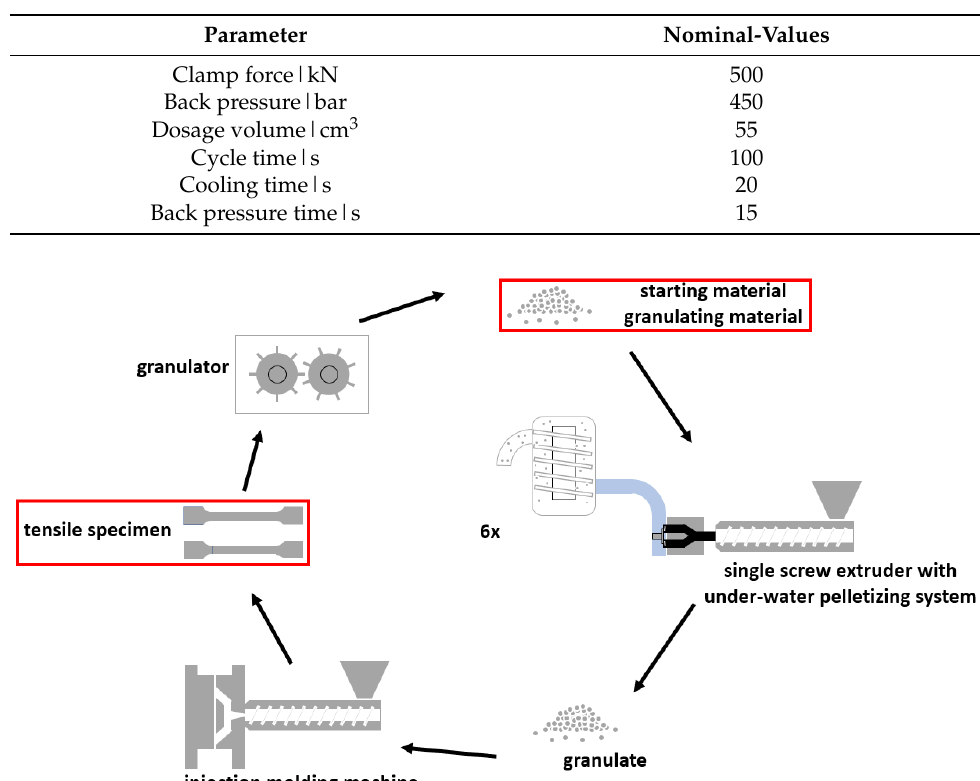
Table 4. Additional processing parameters of the injection molding machine.